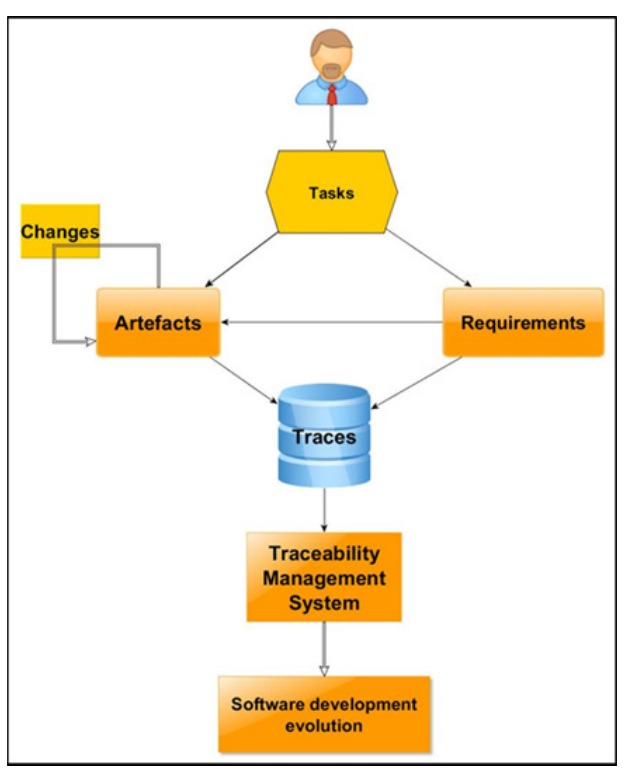
Fig. 3. The proposed